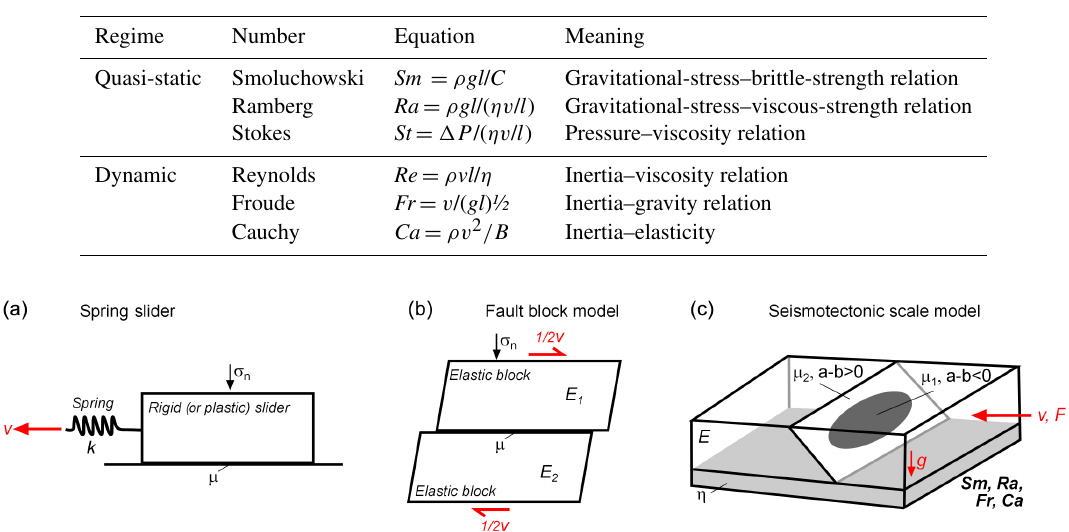
Table 2. Dimensionless numbers used in analogue earthquake models (see text for discussion).